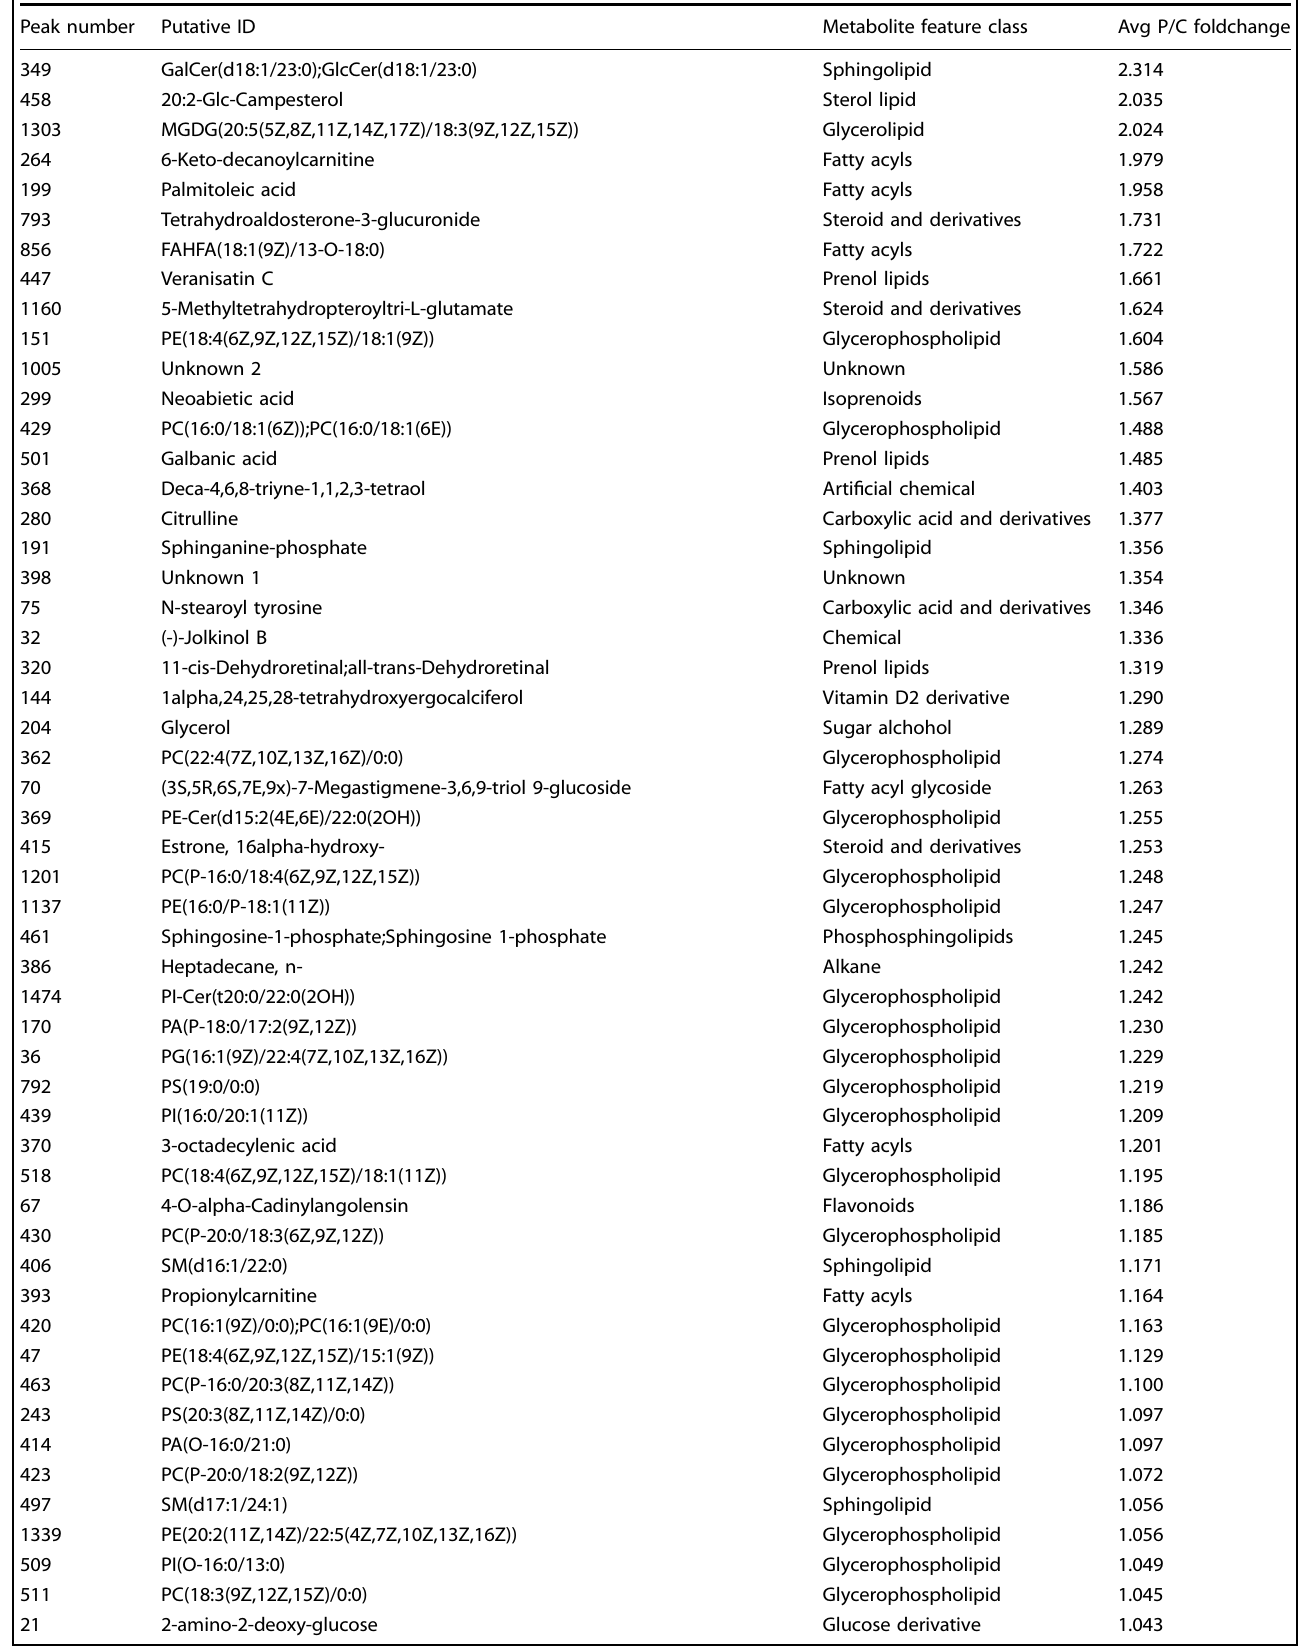
Table 2. Key predictive metabolite